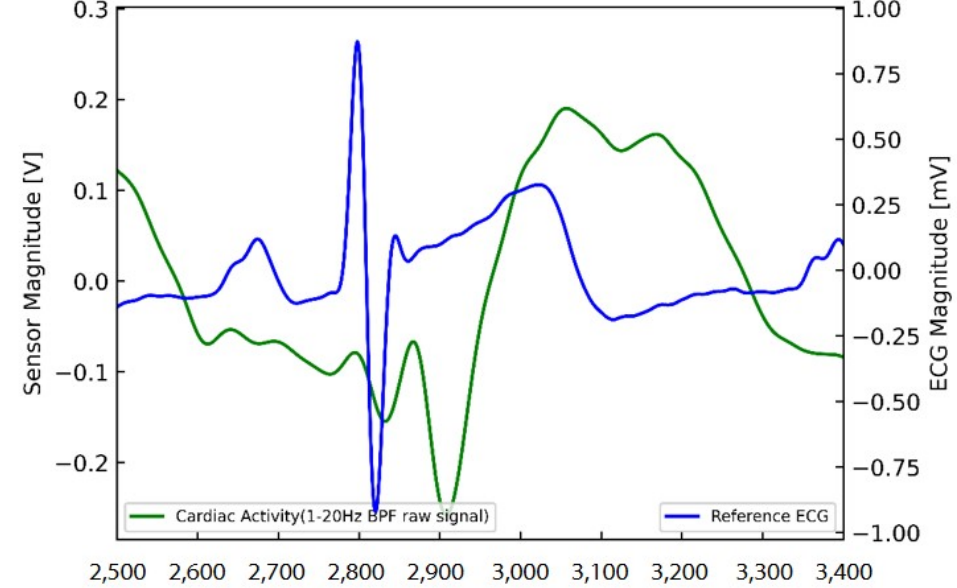
Figure 3. Time delay between ECG and fabric loop sensor signals.